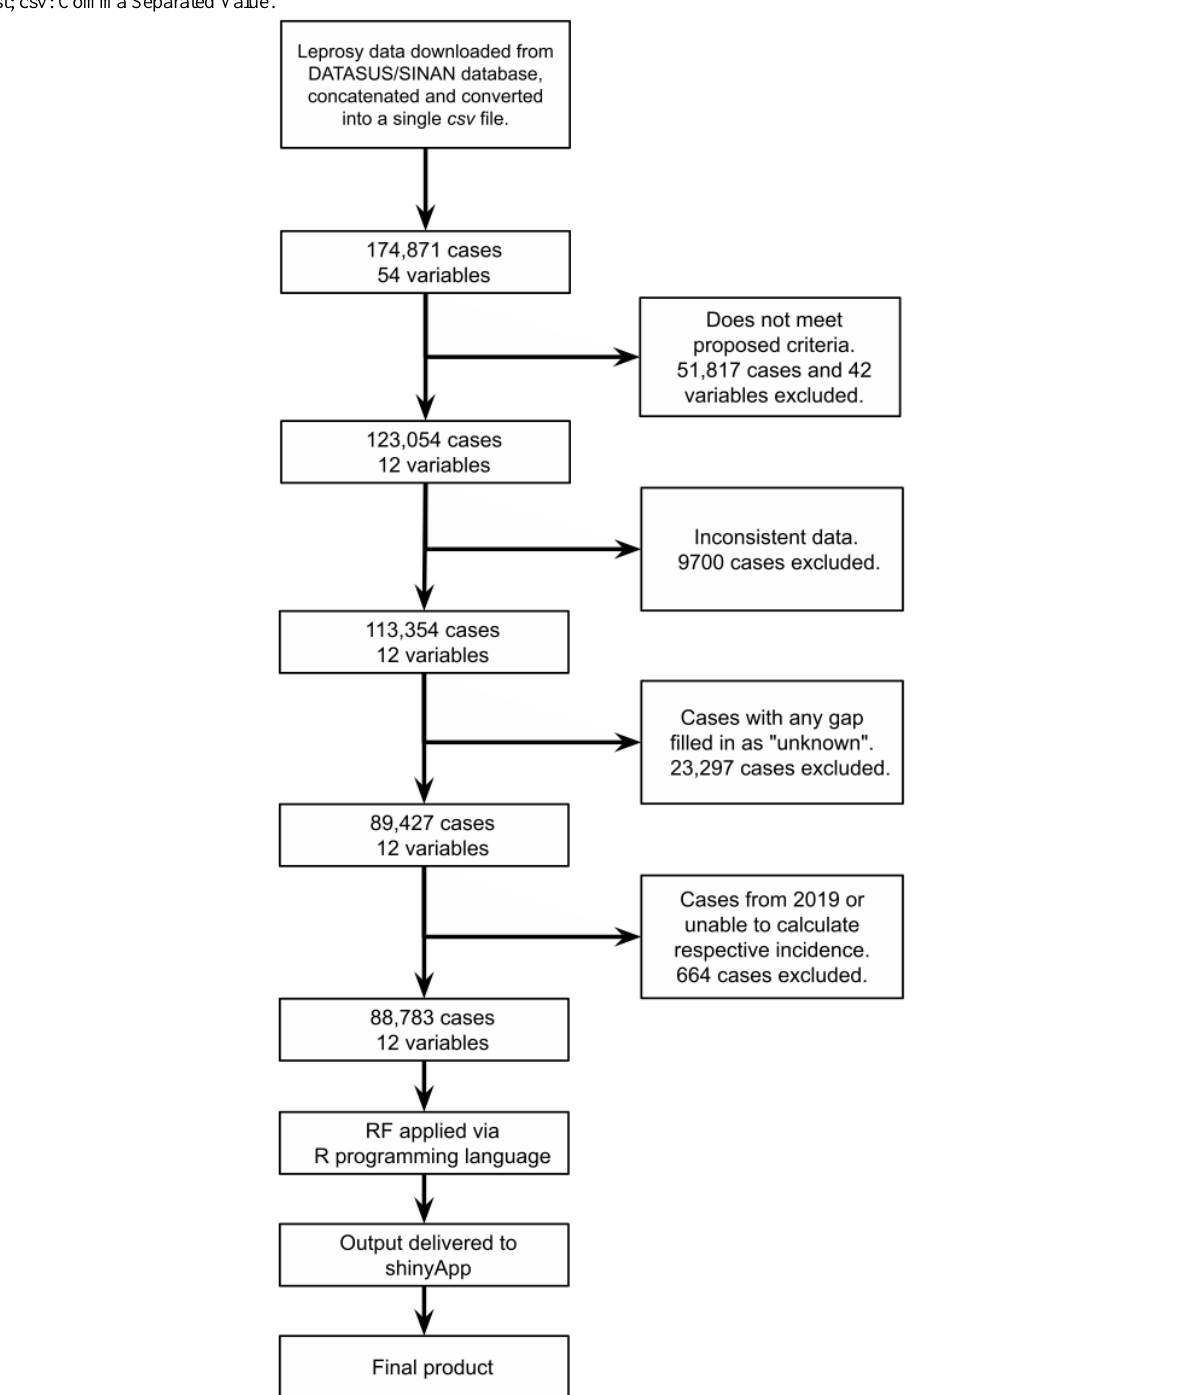
Figure 1. Flow diagram summarizing the data-processing and app-building steps. SINAN: Sistema de Informação Nacional de Agravos de Notificação (National Notifiable Diseases Information System); DATASUS: DATASUS: Sistema Único de Saúde (Unified Health System) data portal; RF: random forest; csv: Comma Separated